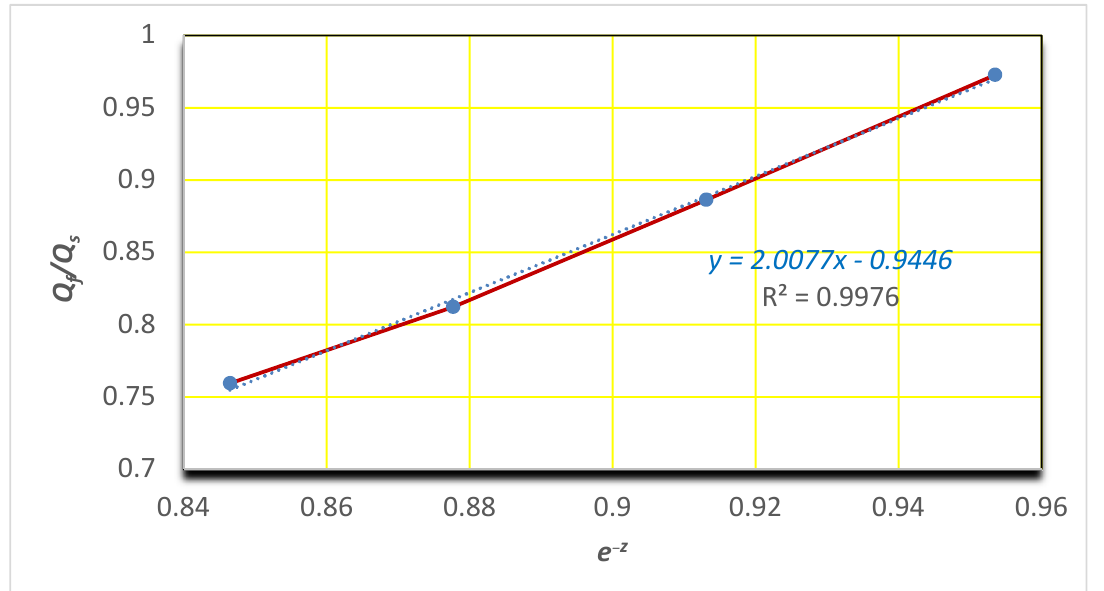
Figure 4. Variation in Q f /Q s with e − z (Lorenz–Park graph).